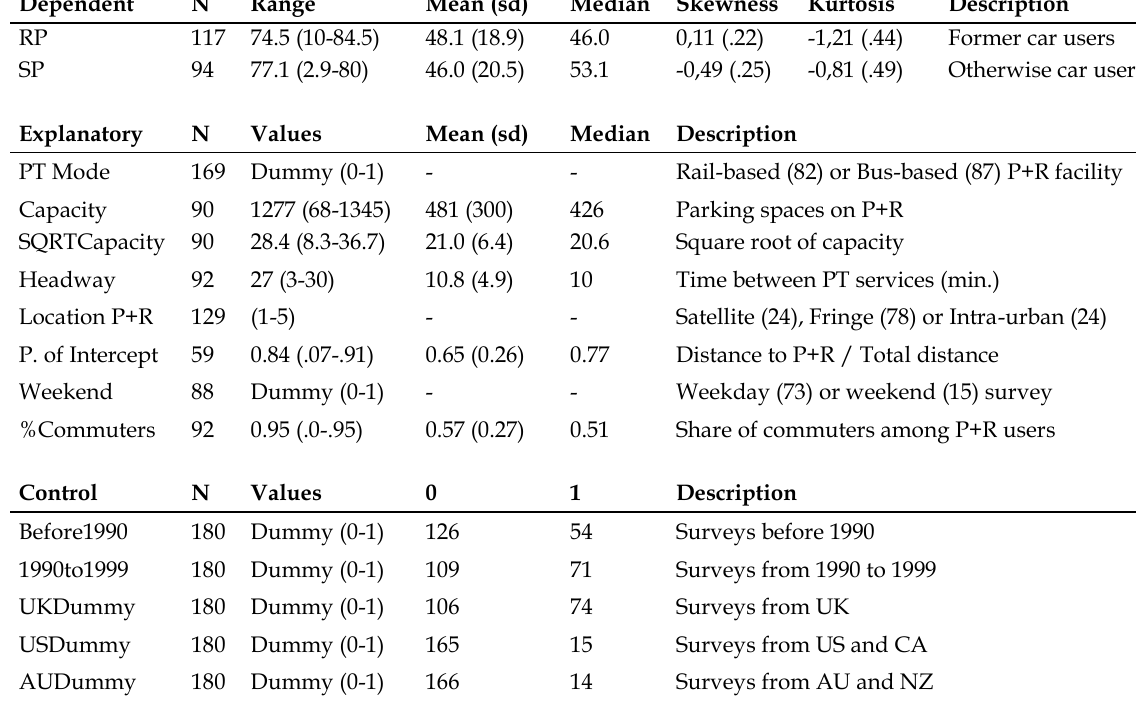
Table 2. Variables included in the